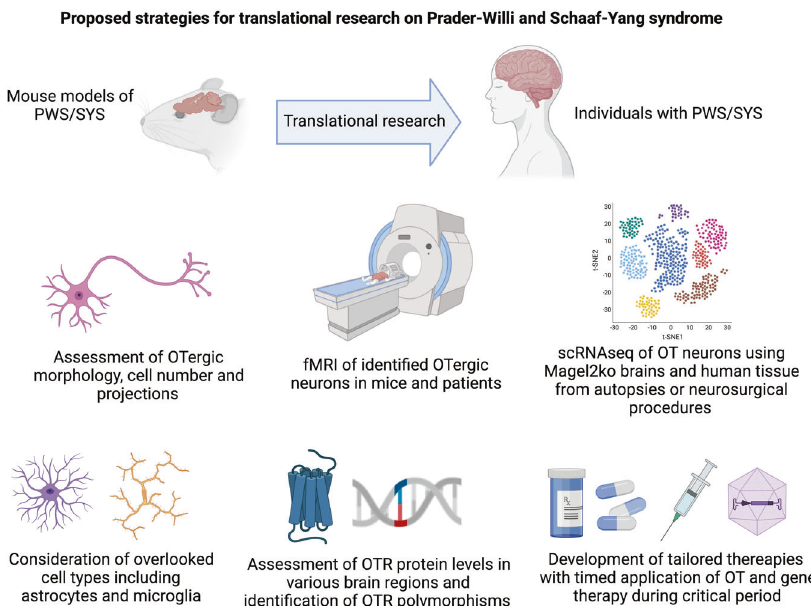
Fig. 3 Novel strategies for oxytocin-based translational research in PWS and SYS. Anatomical, functional, molecular, genetic, and pharmacological research directions to study the role of OT in PWS and SYS.